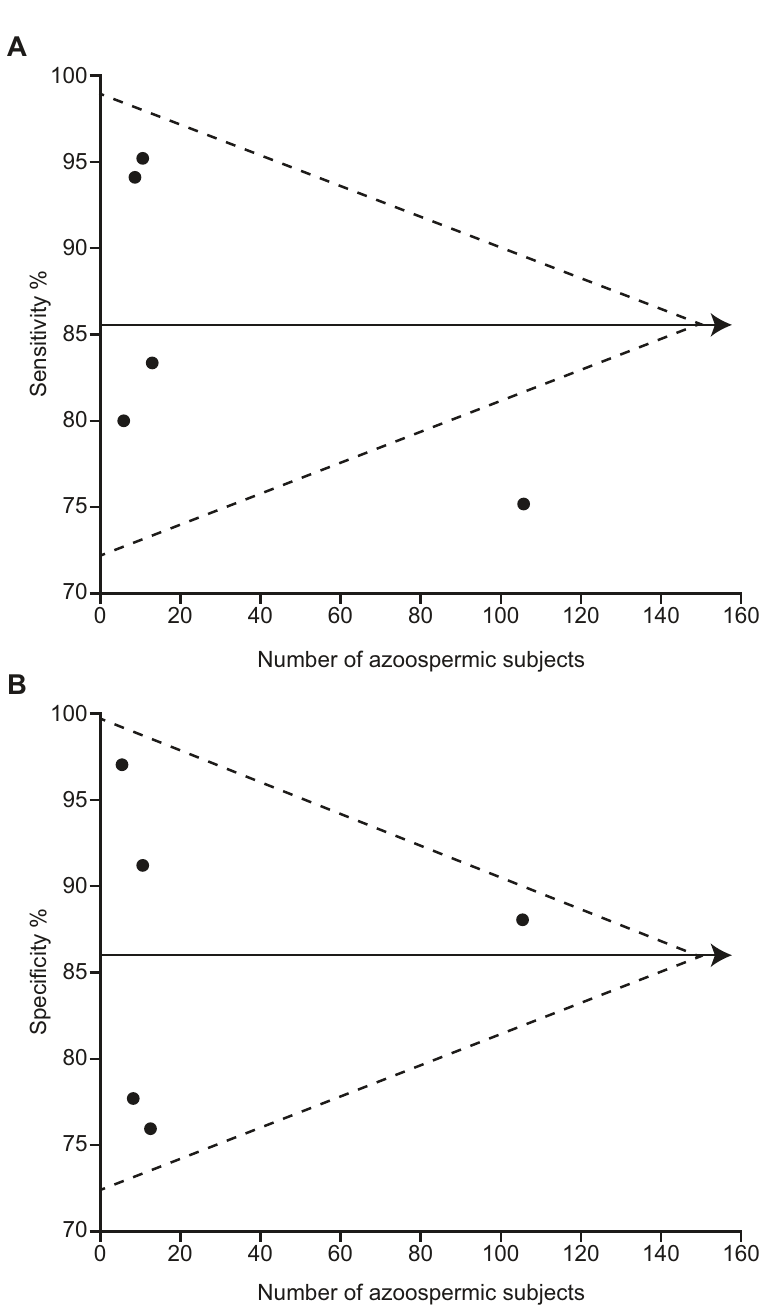
Fig 2. Funnel plots for specificity (upper panel) and sensitivity (lower panel) relating study size to reported diagnostic accuracyfor the five studies listed in Table 1. The Chi-squared statistical test for funnel plot asymmetry did not reach statistical significance(p = 0.32 for sensitivity; p = 0.17 for specificity), suggestinga lack of publication